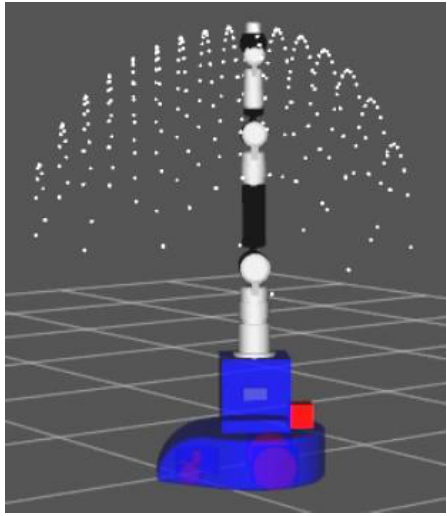
Figure 9. Optimized workspace for robot arm in RVIZ.